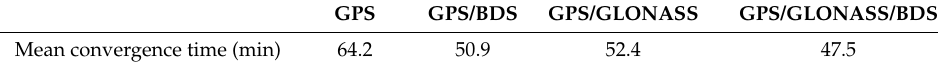
Figure 6. The difference between the PPP kinematic and RTK solutions (GPS/BDS and GPS/GLONASS/BDS). 5. Conclusions In this study, the performance of multi-constellation kinematic PPP was assessed in terms of the positioning accuracy and convergence time. A kinematic experimental dataset was processed using a self-developed software based on the multi-constellation kinematic PPP model, Kalman filter and stochastic models. Based on the discussions above, we drew the following conclusions: